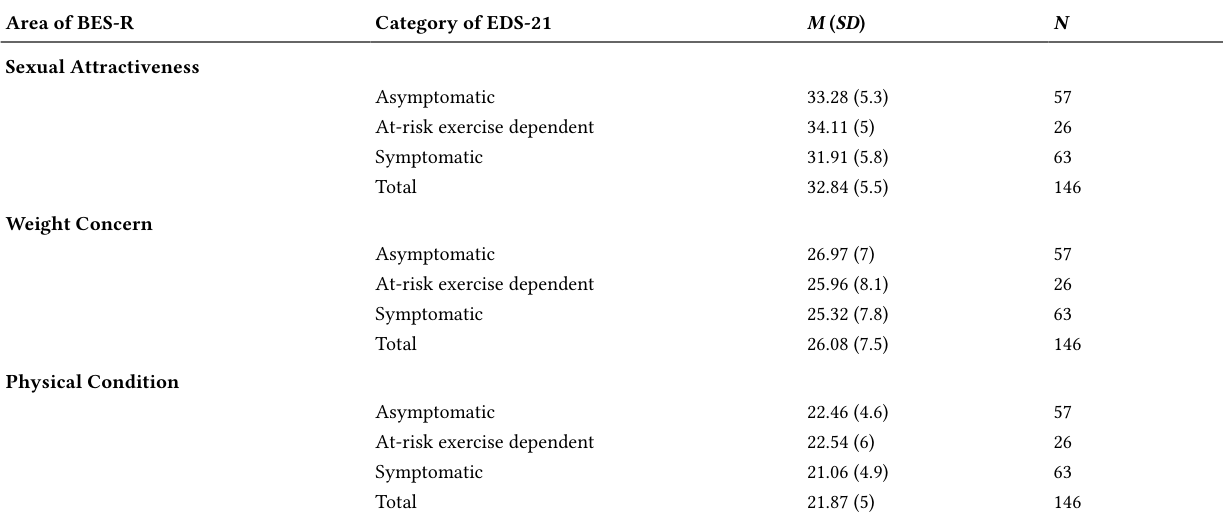
Mean Scores, Standard Deviations and Sample Size for Female Gym-Goers Between Categories of Exercise Dependence and Areas of Body Esteem Area of BES-R